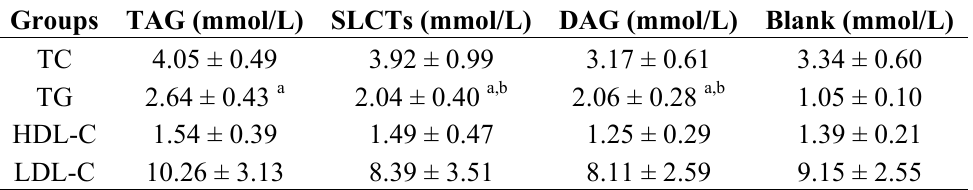
Table 3. Plasma analysis of fasting